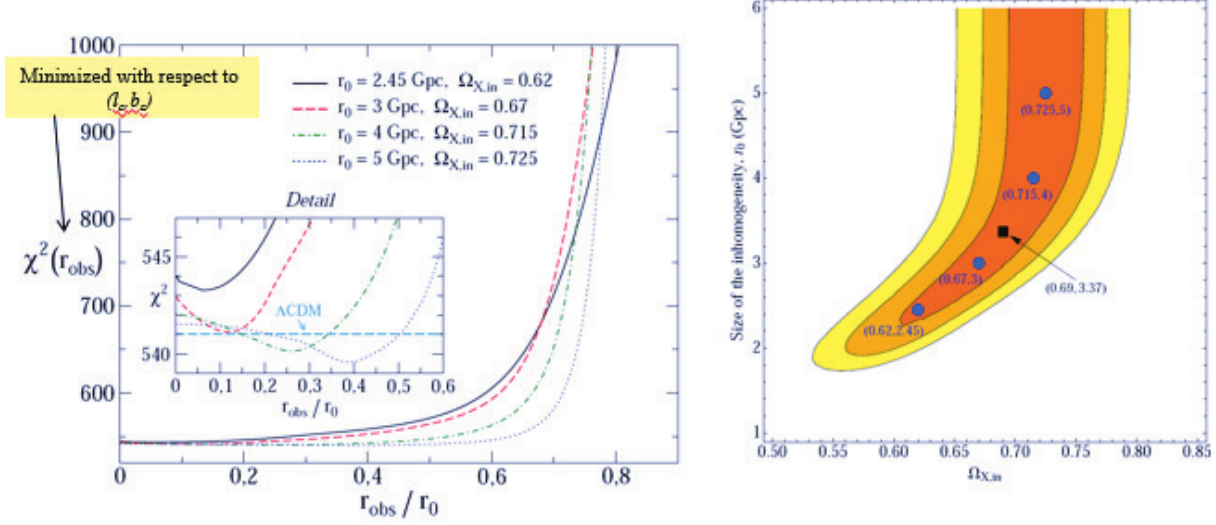
Figure 12. The dependence of χ 2 on the displacement r of the observer (left panel). obs Minimization with respect to the direction of the inhomogeneity center has been performed. , Ω We have considered four pairs ( r ) that provide good fits for the on center observer 0 X, in (right panel). Notice that improved fit with respect to Λ CDM (horizontal blue dashed line) > 3 . 5 Gpc) (from is obtained only for large scale inhomogeneities ( r 0